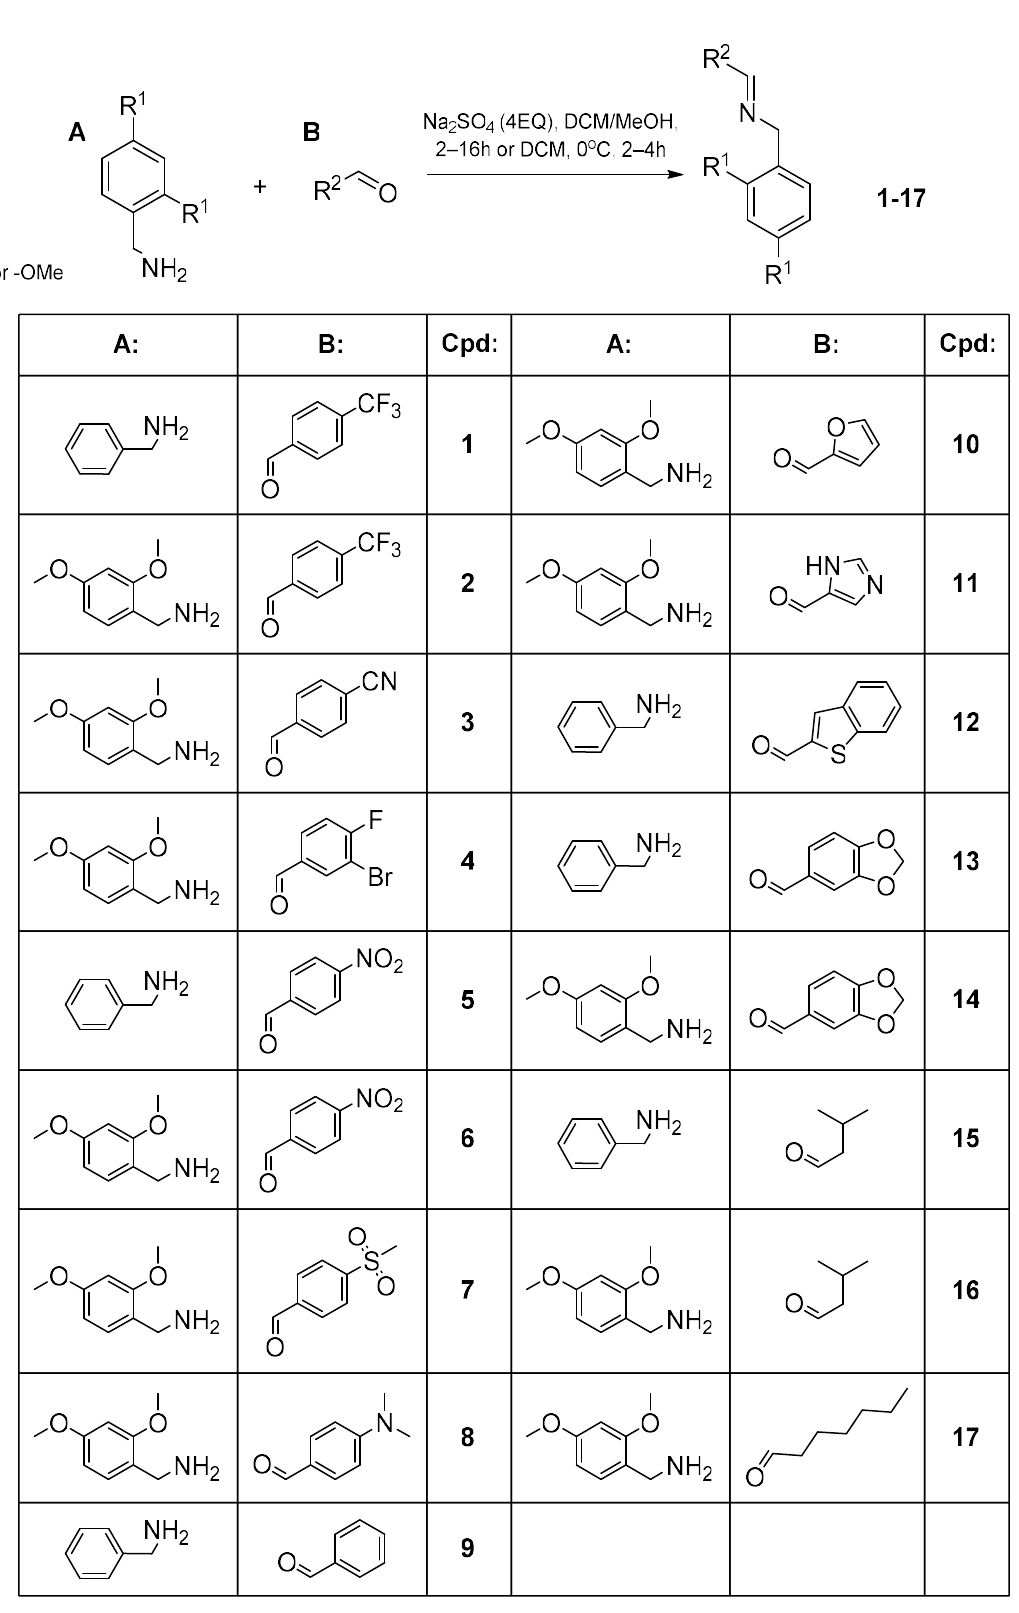
Scheme 1. Reaction conditions for synthesis of imines and structures of products ( 1–17 ). Reagents and reaction conditions: Na 2 SO 4 (4EQ), DCM/MeOH, 2–16 h or DCM, 0 °C, 2–4 h. We initially focused our efforts on the preparation of monocyclic ß-lactams using ke- tenes obtained from t -butylcarbamate- or benzylcarbamate-protected glycine and imines